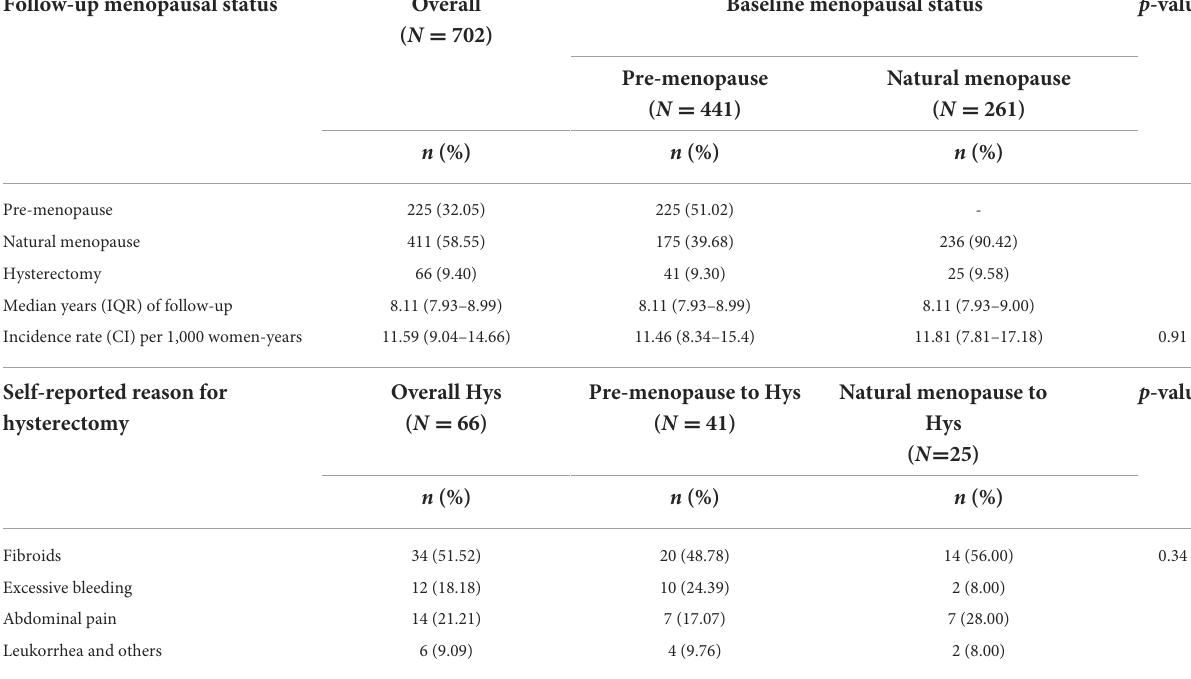
TABLE 2 Incidence and self-reported reason for hysterectomy in the studied